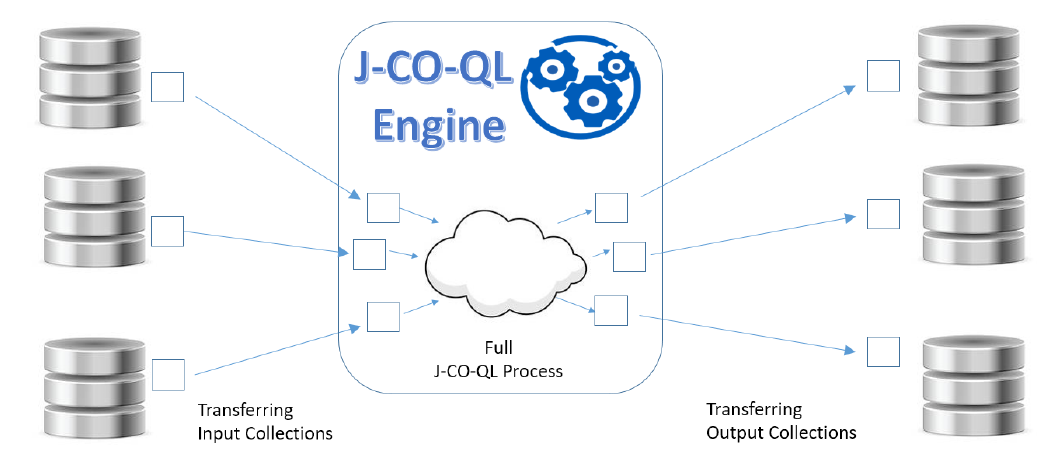
Figure 2. General approach to process collections (represented as rectangles): no processing activities on data